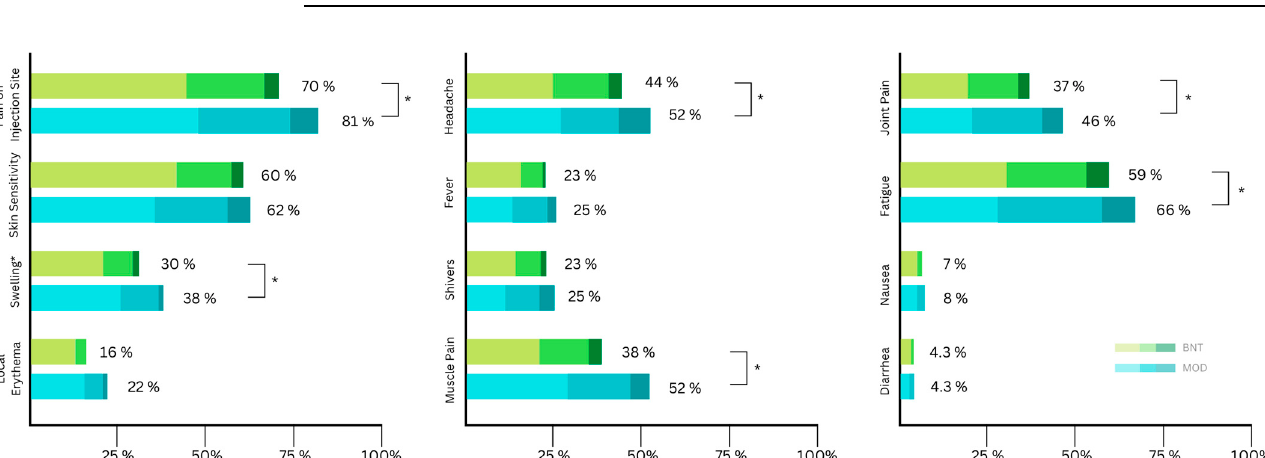
Figure 3. Distribution of self-reported local side effects according to symptom severity (mild, moderate, severe) after the third (booster) vaccination (BNT: Biontech/Pfizer (BNT162b2); MOD: Moderna (mRNA-1273)). Asterisks indicate significant differences in severity.